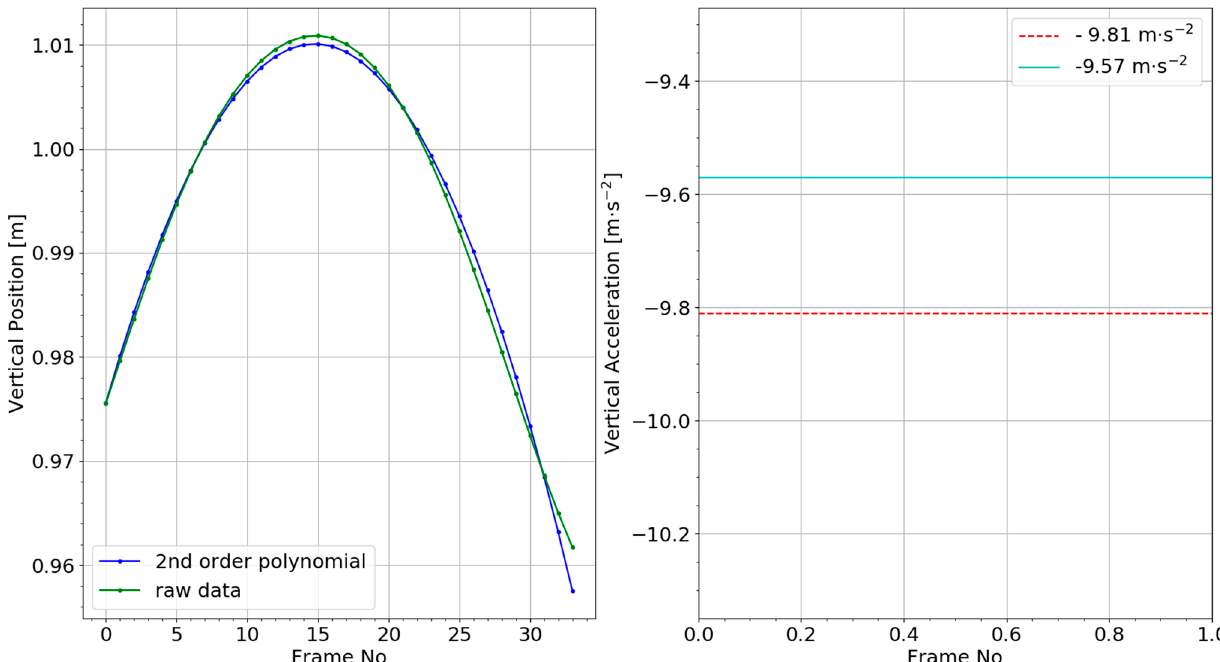
Figure A2. Example CoM model accuracy check for an individual participant’s flight phase using marker-based data. Unfiltered vertical CoM trajectory (left – green) is shown with a 2 nd order polynomial fit to the data (left- blue). The double differentiated result (right - cyan) provides an indication of the accuracy of the CoM model.